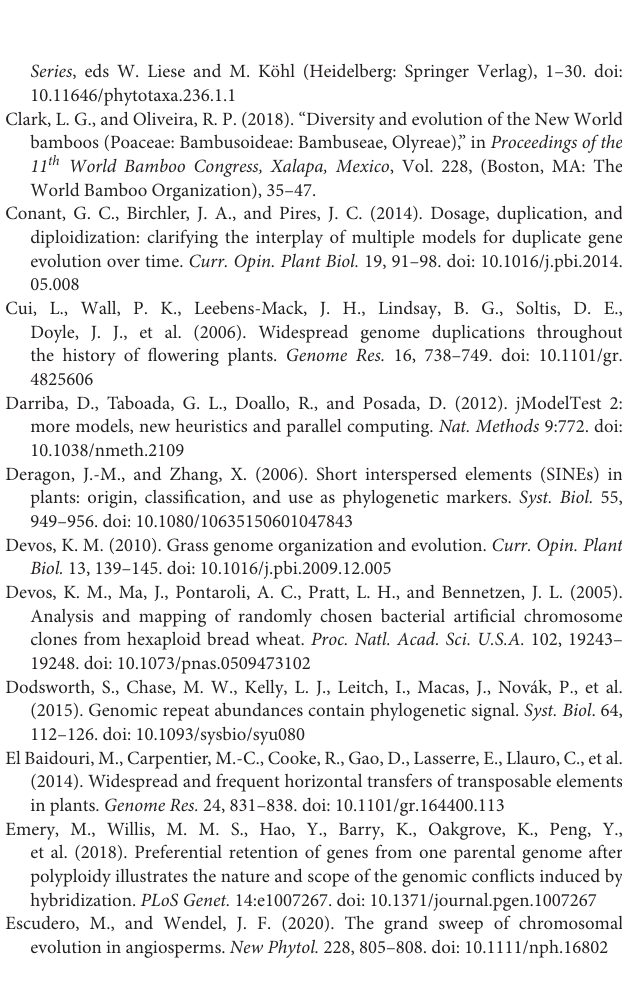
Supplementary Figure 1 | Phylogenetic reconstruction with 115 bamboo plastomes. The phylogenetic reconstruction is based on the alignment of 115 full plastome sequences. Within the 115 sequences, 51 correspond to the species used in the main text and sequenced for this study (green font), 50 correspond to previously published plastomes (available on database) and two are non-bamboo species used as outgroups ( Lolium and Zizania aquatica ). Statistical support is shown at the nodes. Supplementary Figure 2 | Maximum Likelihood phylogenetic reconstruction with 51 species. Supplementary Figure 3 | Phylogenetic topologies of 20 nuclear genes. Branches of the Olyreae clade are green-colored. Supplementary Table 1 | Additional plastomes included from GenBank for the 115-plastome analysis. Supplementary Table 2 | Genome size values of the 51 sequenced